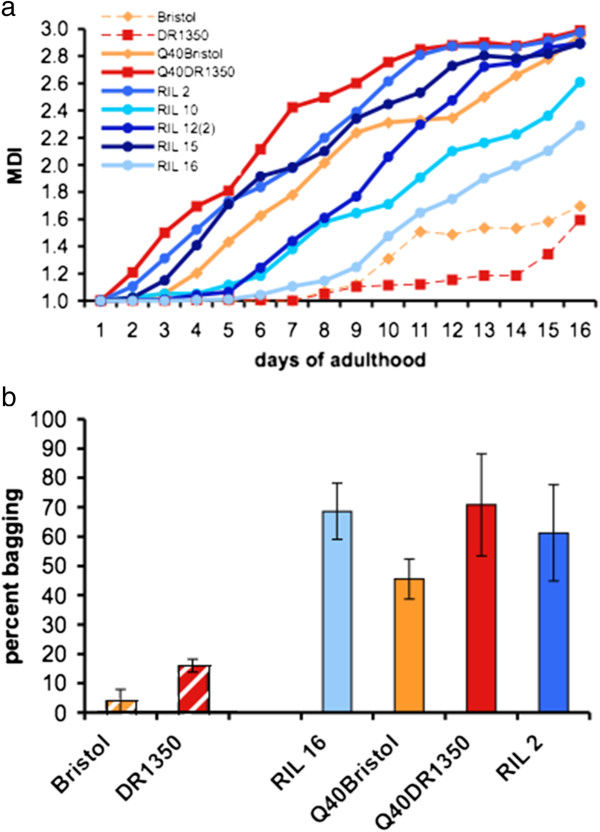
Large variation in toxicity correlates. (a) Progressive increase in muscle dysfunction index (MDI) during adulthood and aging of indicated strains: MDI is 1 when all animals on the plate move spontaneously, and MDI is 3 when all are paralyzed. The curves are a rolling average with a period of 2 days. (b) Internal hatching (bagging) phenotype due to dysfunction in reproductive muscles, scored over the entire egg-laying period. Data are mean ± SD, at least 30 animals per trial, n = 3 trials.